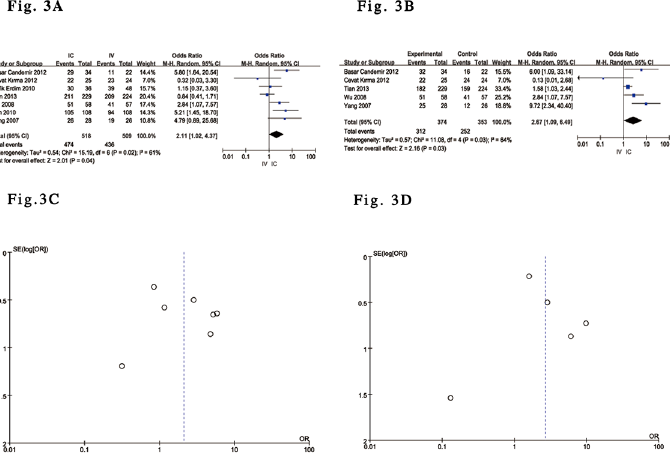
Fig 3. Forest plot of complete perfusion and TMP grade 3 in ACS patients. (A). Forest plot for increasing the frequency of complete perfusion based on a random-effects model in ACS patients treated with IC vs. IV administration of tirofiban. (B). Forest plot for increasing the frequency of TMP grade 3 based on a random- effects model in ACS patients treated with IC vs. IV administration of tirofiban. (C). Funnel plot of complete perfusion used to identify evidence of publication bias. (D). Funnel plot of TMP grade 3 used to identify evidence of publication bias.